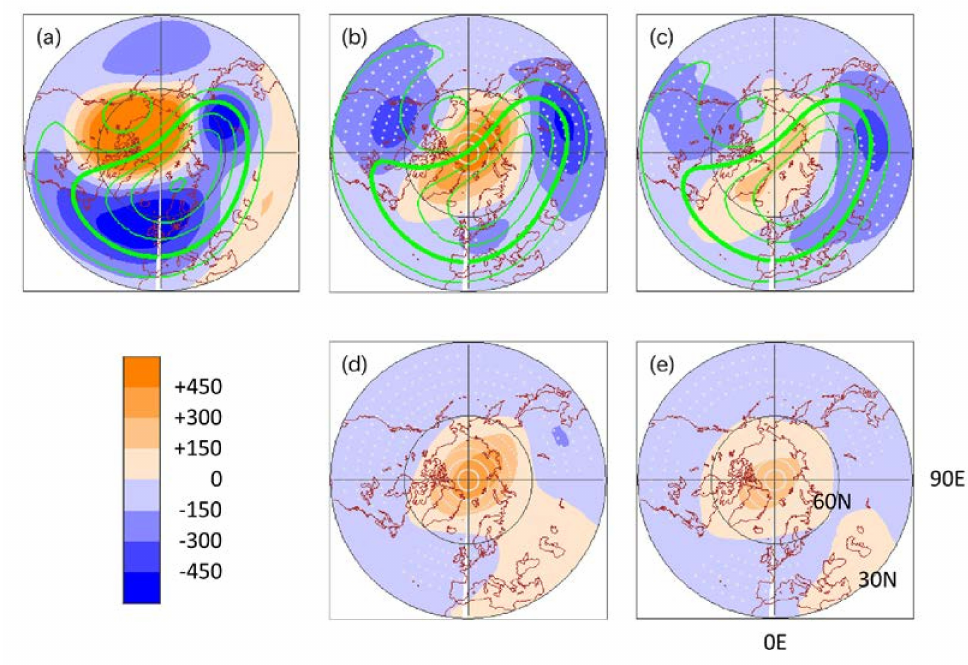
Figure 4. ( a ) Map of the JRA-55 10 hPa geopotential height averaged for 5 days around RD (RD ± 2) for the first cluster in green contours, as in Figure 1b. The values inside the 30,000 m thick contour are lower than it. Color shadings plot di ff erences from the JRA-55 climatology in the same period. Panel ( b ) is similar, but for the mean of the 29 MSSW members for the MSSW ensemble (N27 initialization). Color shadings plot di ff erences from the JRA-55 data ( a ). Panel ( c ) is similar, but uses the 22 non-MSSW members. Panel ( d ) plots the di ff erence of ( b ) from ( c ). Panel ( e ) plots 5-day mean 10 hPa height regressed onto the 7-day mean (RD-6 to RD) heat flux, using all ensemble members. Dots are plotted where the di ff erences in ( b – d ) or correlations in ( e ) are statistically significant. The dots are plotted every two grids for each of longitude and latitude at most to avoid too dense